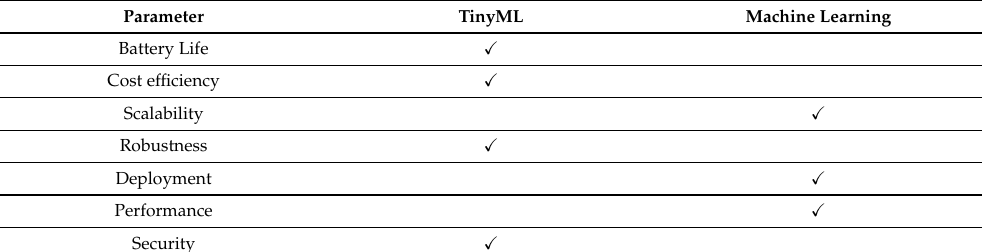
Table 8. TinyML applications vs. ordinary Machine Learning applications in network